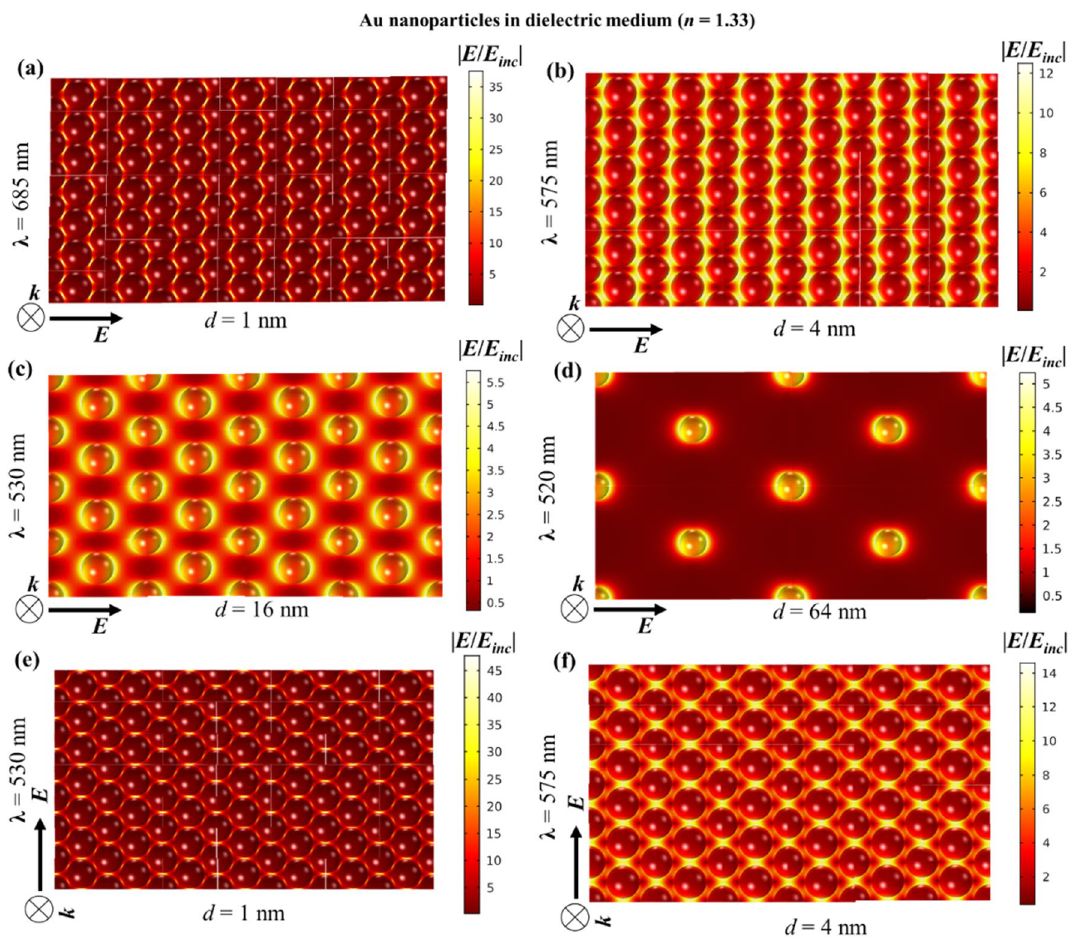
Figure 7. Near-field enhancement w.r.t . the incident field for 2D hexagonal monolayer array of 20 nm Au nanoparticle in dielectric medium ( n = 1.33) for different interparticle gaps, d : ( a ) 1 nm, ( b ) 4 nm, ( c ) 16 nm and ( d ) 64 nm. ( e ) and ( f ) Shows the near-field profiles at vertical polarization for interparticle gaps 1 and 4 nm respectively. At normal incidence i.e. θ = 0°, ( a – d ) are for horizontal polarization i.e. φ = 0° and vertical polarization i.e. φ =